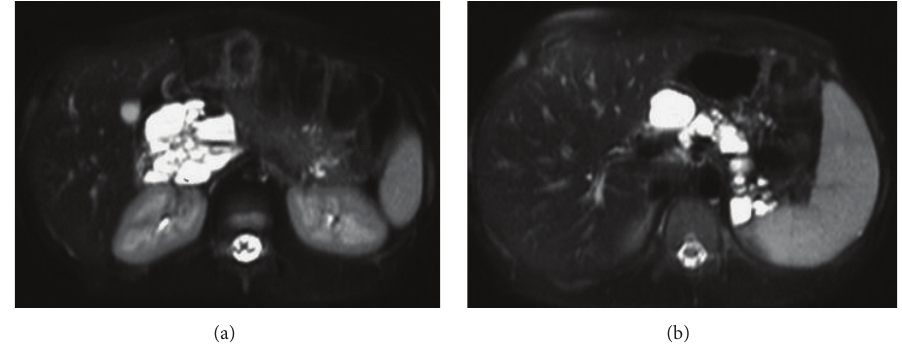
Figure 1: (a) T2-weighted fat-saturated transverse MR image obtained at the level of the pancreatic head shows multiple, high signal cysts of varying size in the expected region of the head of the pancreas without identifiable pancreatic tissue. (b) T2-weighted fat-saturated transverse MR image obtained at the level of the body and tail of the pancreas reveals complete replacement by multiple, bright-signal cystic masses of varying size with thin and smooth walls.